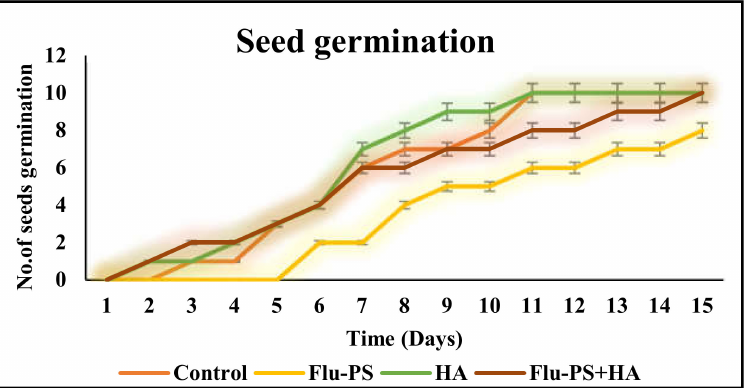
Figure 6. The seed germination rate for Solanum lycopersicum is shown in this line graph (control, Flu − PS, HA, and Flu − PS+HA).